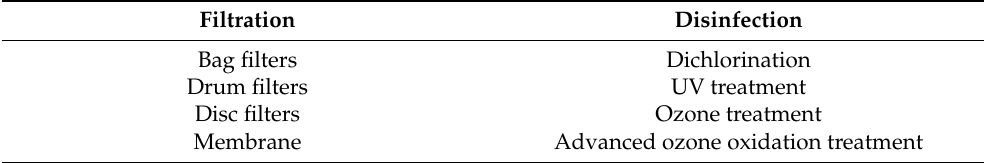
Table 3. Technologies for filtration and disinfection of tertiary